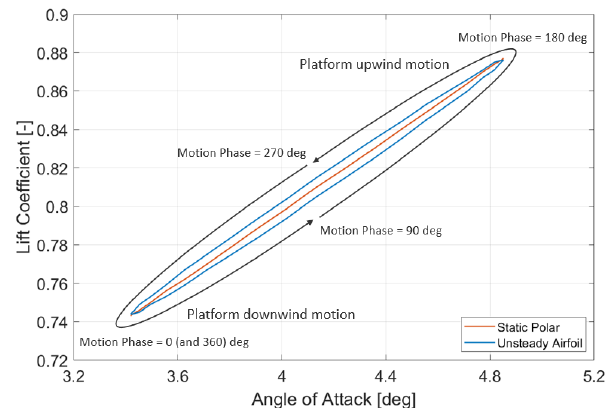
Figure 15. Lift coefficient versus angle of attack for a numerical model (NREL) using a lifting line with static polars or unsteady airfoil